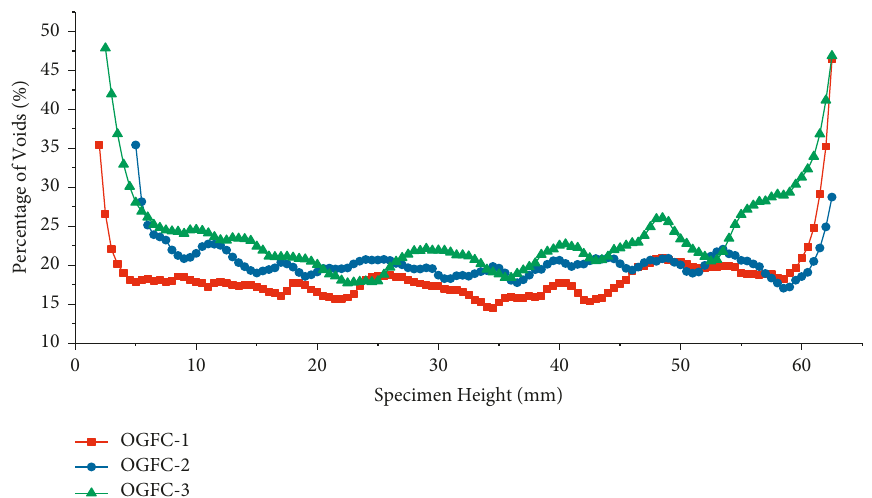
Figure 2: Percentage of void distribution along the height of the